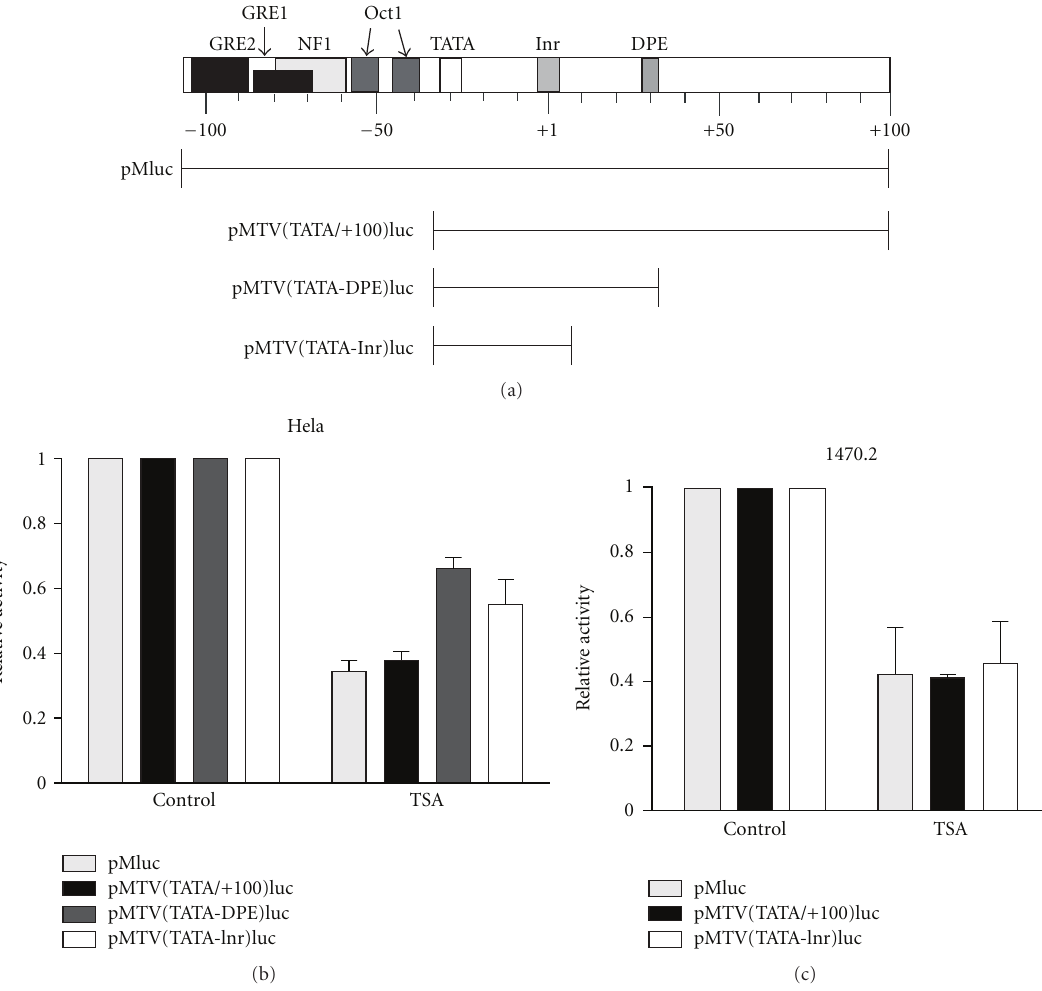
Figure 1: The MMTV core promoter confers transcriptional repression by the HDAC inhibitor, TSA. Various luciferase reporter constructs containing fragments of the MMTV promoter shown in (a) were transiently transfected into Hela or 1470.2 cells and treated with or without TSA (50ng/ml) for 6h prior to harvest. Cell lysates were assayed for luciferase activity, and these values were normalized to protein concentrationfor each sample. Normalized values for untreated (control) sampleswere set to 1, and values for treated sampleswere expressed as a fraction. Statistical analysiswas performed on results from 3 to 7 independent experiments. Results from Hela and 1470.2 cells are shown in (b) and (c), respectively. Error bars represent